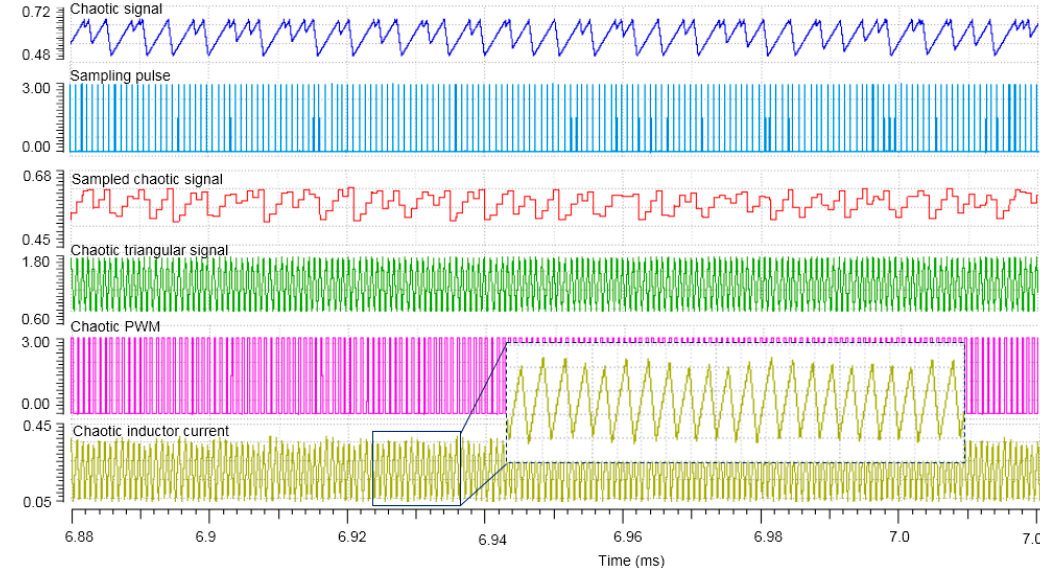
Figure 8. Steady-state time-domain simulation results of the converter in chaotic mode using chaotic triangular ramp generator with slope modulation.